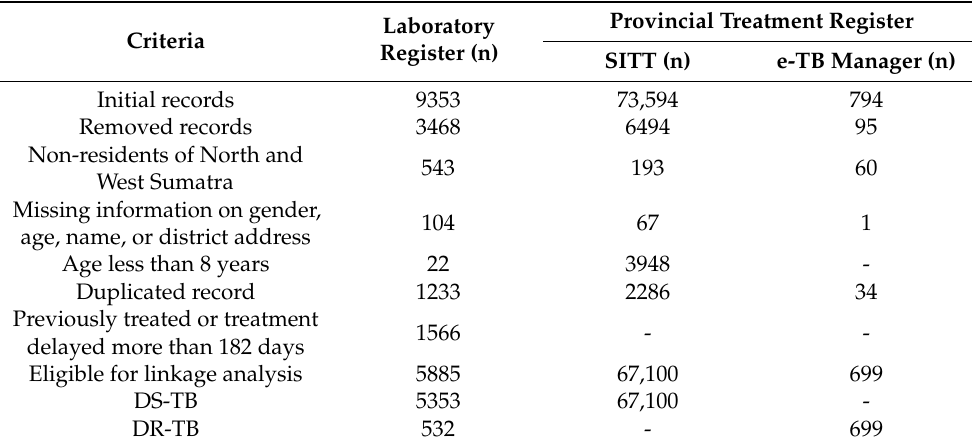
Table 1. Number of records identified from each database of North Sumatra Province and West Sumatra Province between 2017 and 2018.